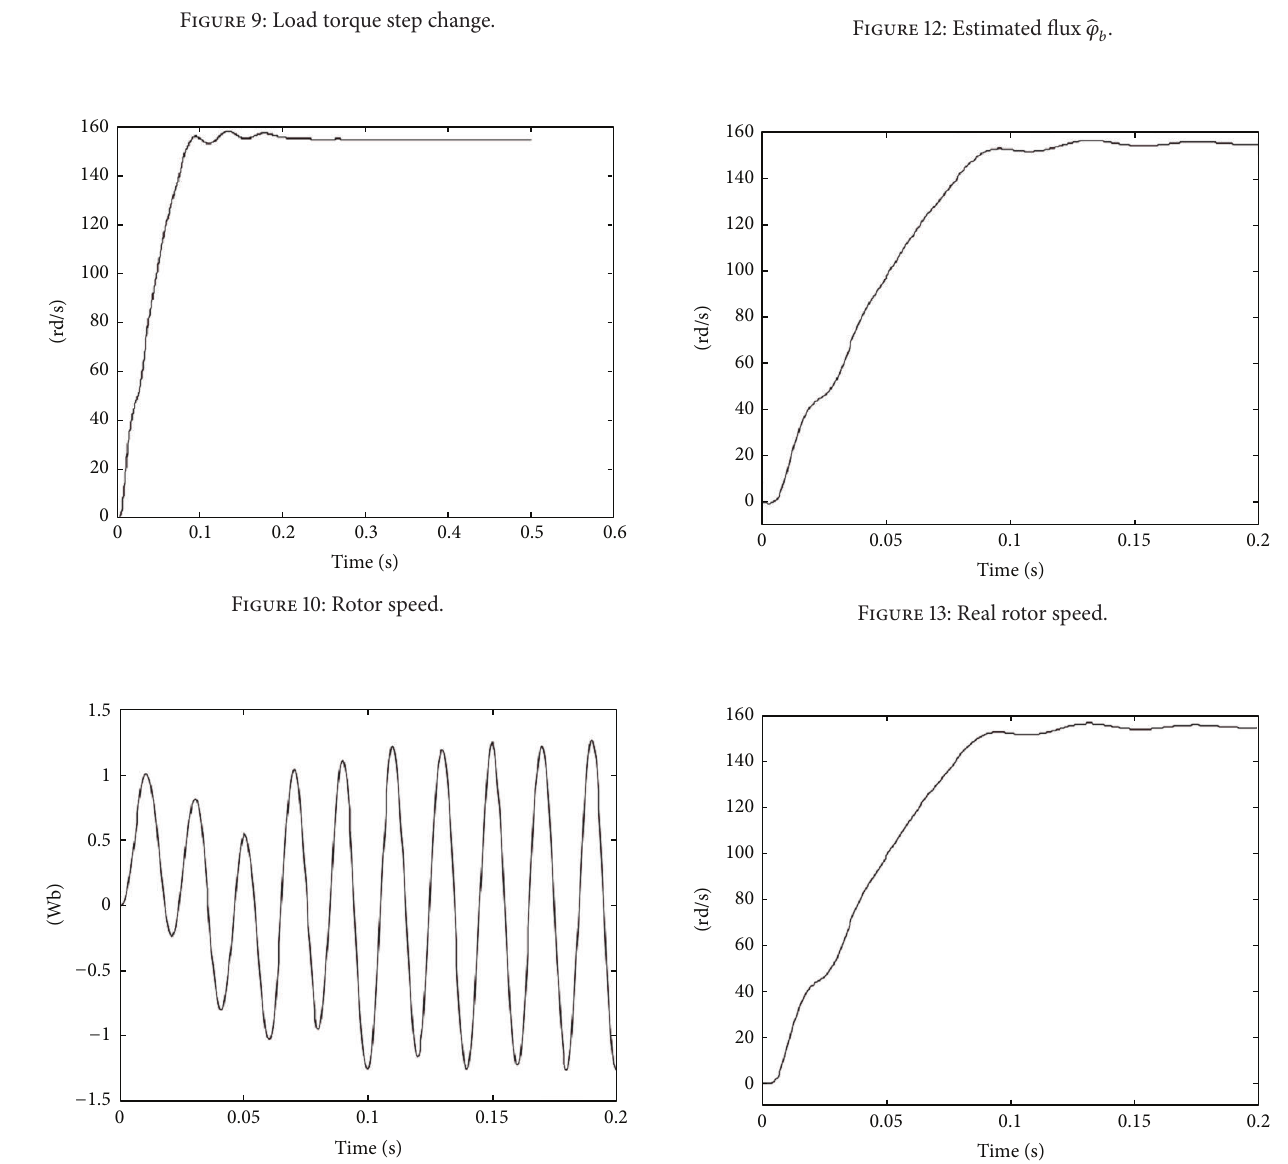
Figure 14: Estimated rotor